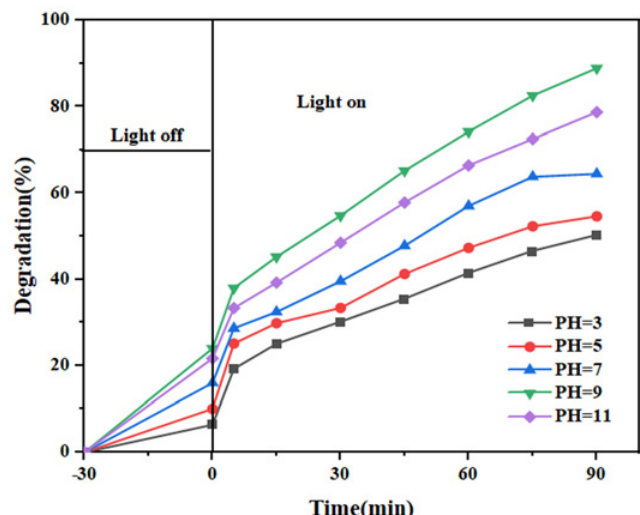
Fig. 4. Effect of pH on photocatalytic degradation of albumin